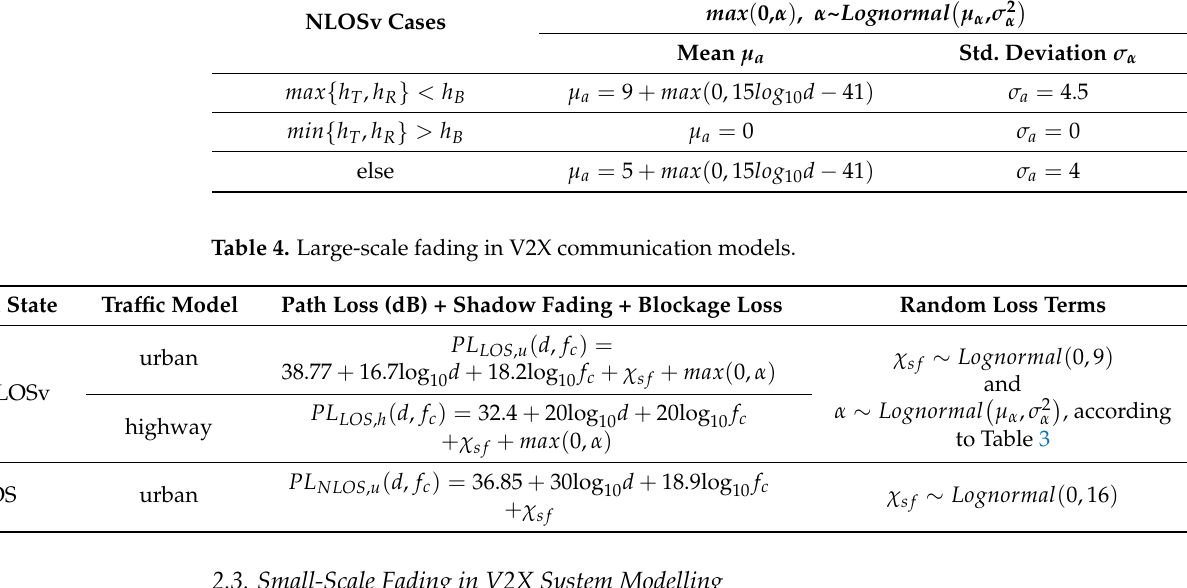
Table 3. NLOSv additional blockage loss.